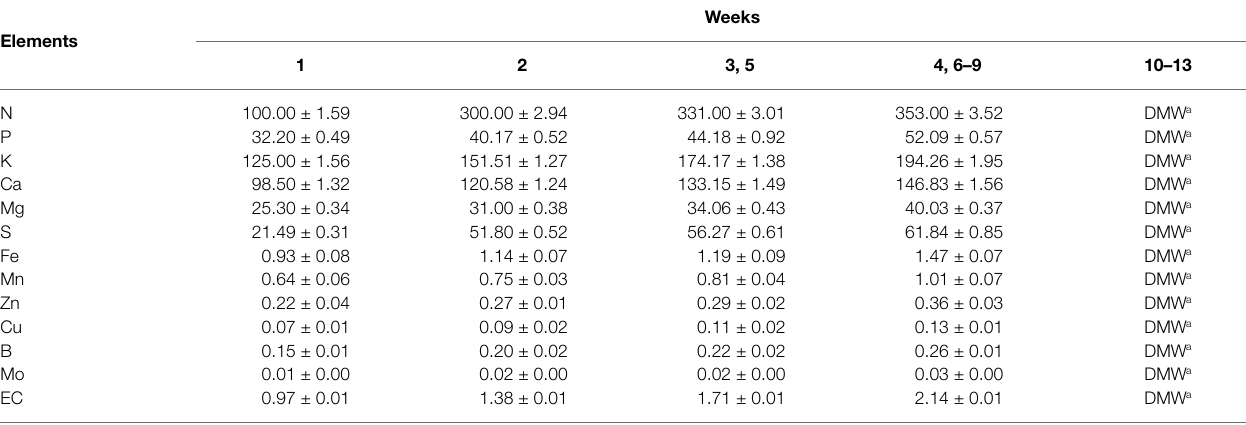
TABLE 3 | Composition of enhanced treatment (ET) nutrient solution with the addition of AAs (mg/L).